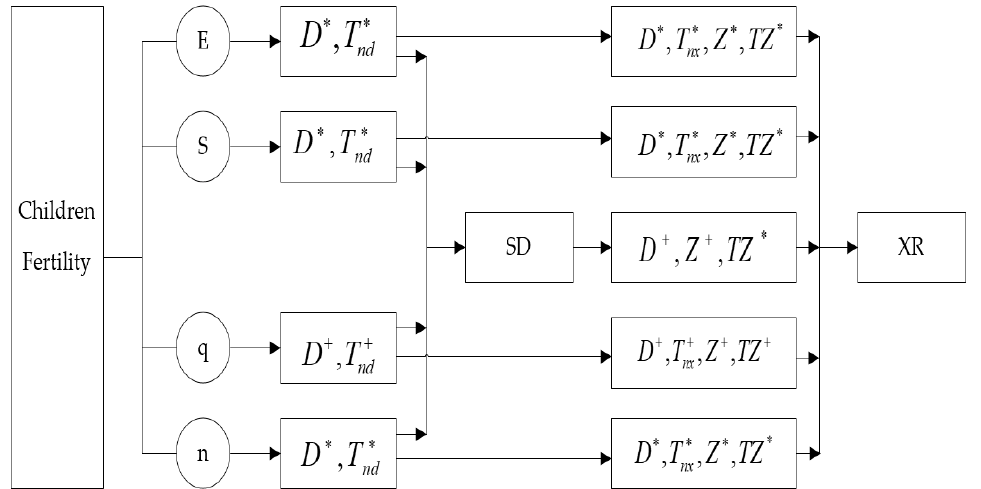
Figure 1. Theoretical mechanisms and effects of fertility, social status, and farmer social trust influence. Note: (1) E, S, and q denote the economic, social, and emotional values of children’s fertility; n represents the number of children, SD represents social status, and XR represents social trust; (2) D stands for direct mechanism; T nd represents the child’s value–social status adjustment mechanism, T nx represents the child’s value–social trust adjustment mechanism, Z represents the intermediary mechanism, and TZ represents the mixed adjustment intermediary mechanism; (3) “*” indicates that the direction of action of the mechanism depends on the combination of parameters, and the direction is uncertain, and “+” indicates positive effect and “–” indicates negative effect.